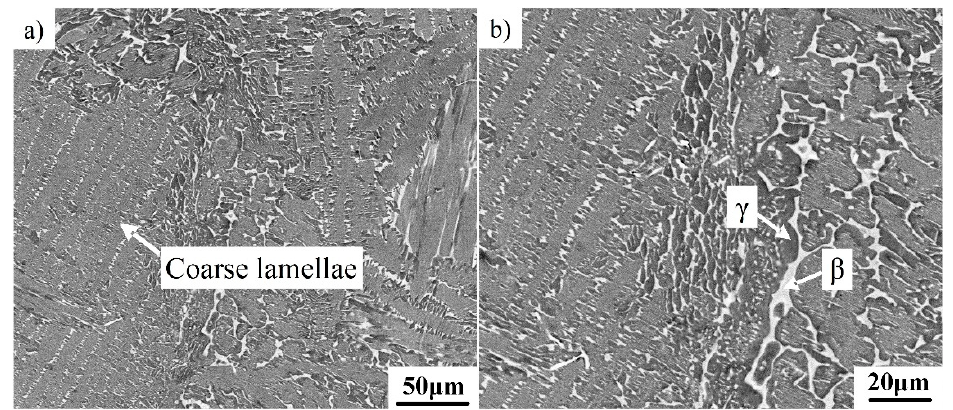
Figure 1. SEM micrograph showing the microstructure of the Ti–43Al–2Cr–0.7Mo–0.1Y ingot. ( a ) Coarse lamellae; ( b ) β and γ phases.